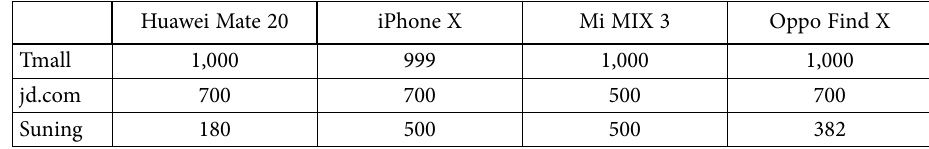
Table 1. The number of comments collected from each phone’s links Huawei Mate 20 iPhone X Mi MIX 3 Oppo Find X Tmall 1,000 999 1,000 1,000 jd.com 700 700 500 700 Suning